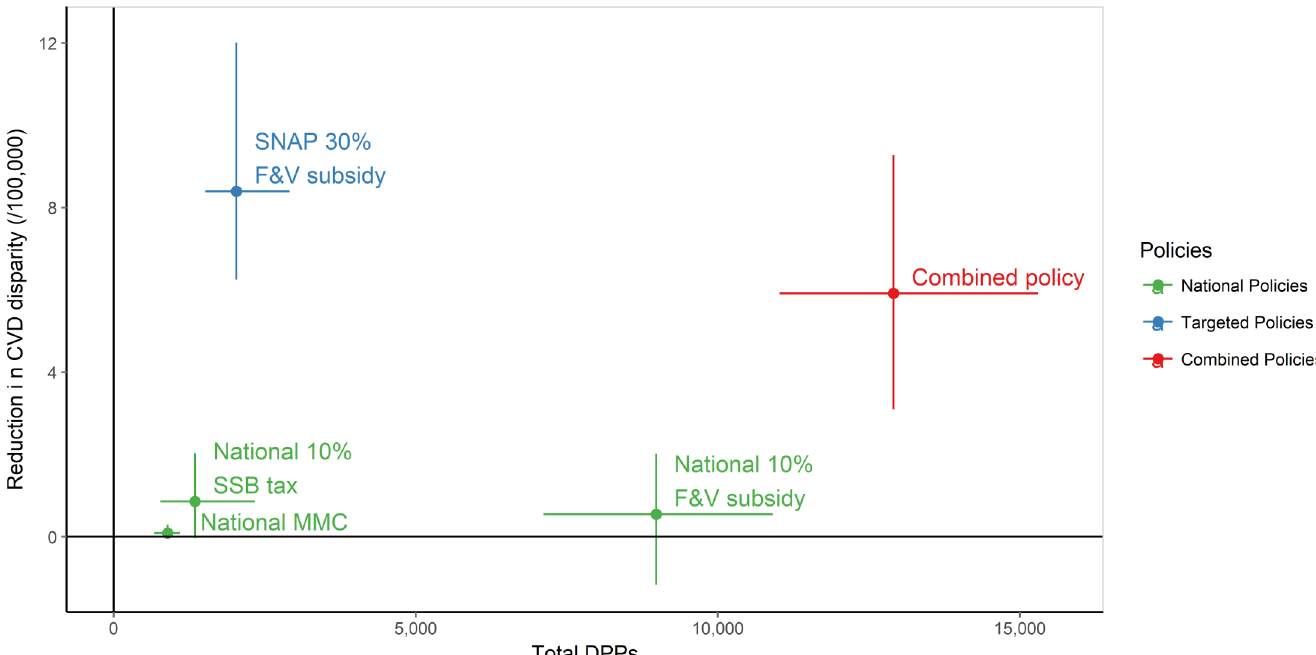
Fig 3. Total deaths prevented or postponed versus change in cardiovasculardisease disparities in 1 y—2030. The reductionin CVD disparities is the difference in DPPs/100,000 population between SNAP participantsand SNAP-ineligible individuals(a positive numberindicatesmore DPPs/100,000 in SNAP participants than in SNAP-ineligible individuals).Point estimate and 95% uncertaintyintervals. CVD, cardiovascular disease;DPPs, deaths prevented or postponed;F&V, fruit and vegetable; MMC, mass media campaign;SNAP, Supplemental NutritionAssistance Program; SSB, sugar- sweetened